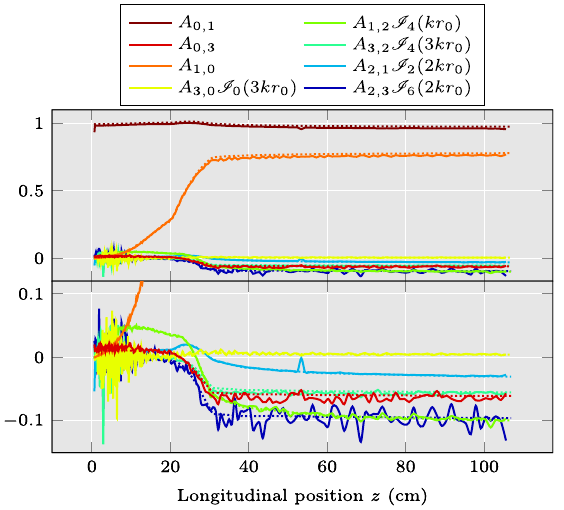
FIG. 17. Comparison between the eight multipole expansion coefficients computed from the HFSS field (solid) and their design values (dotted) for each RFQ cell. The bottom plot enlarges a region of the upper graphic to enhance the visualization of the higher order terms.